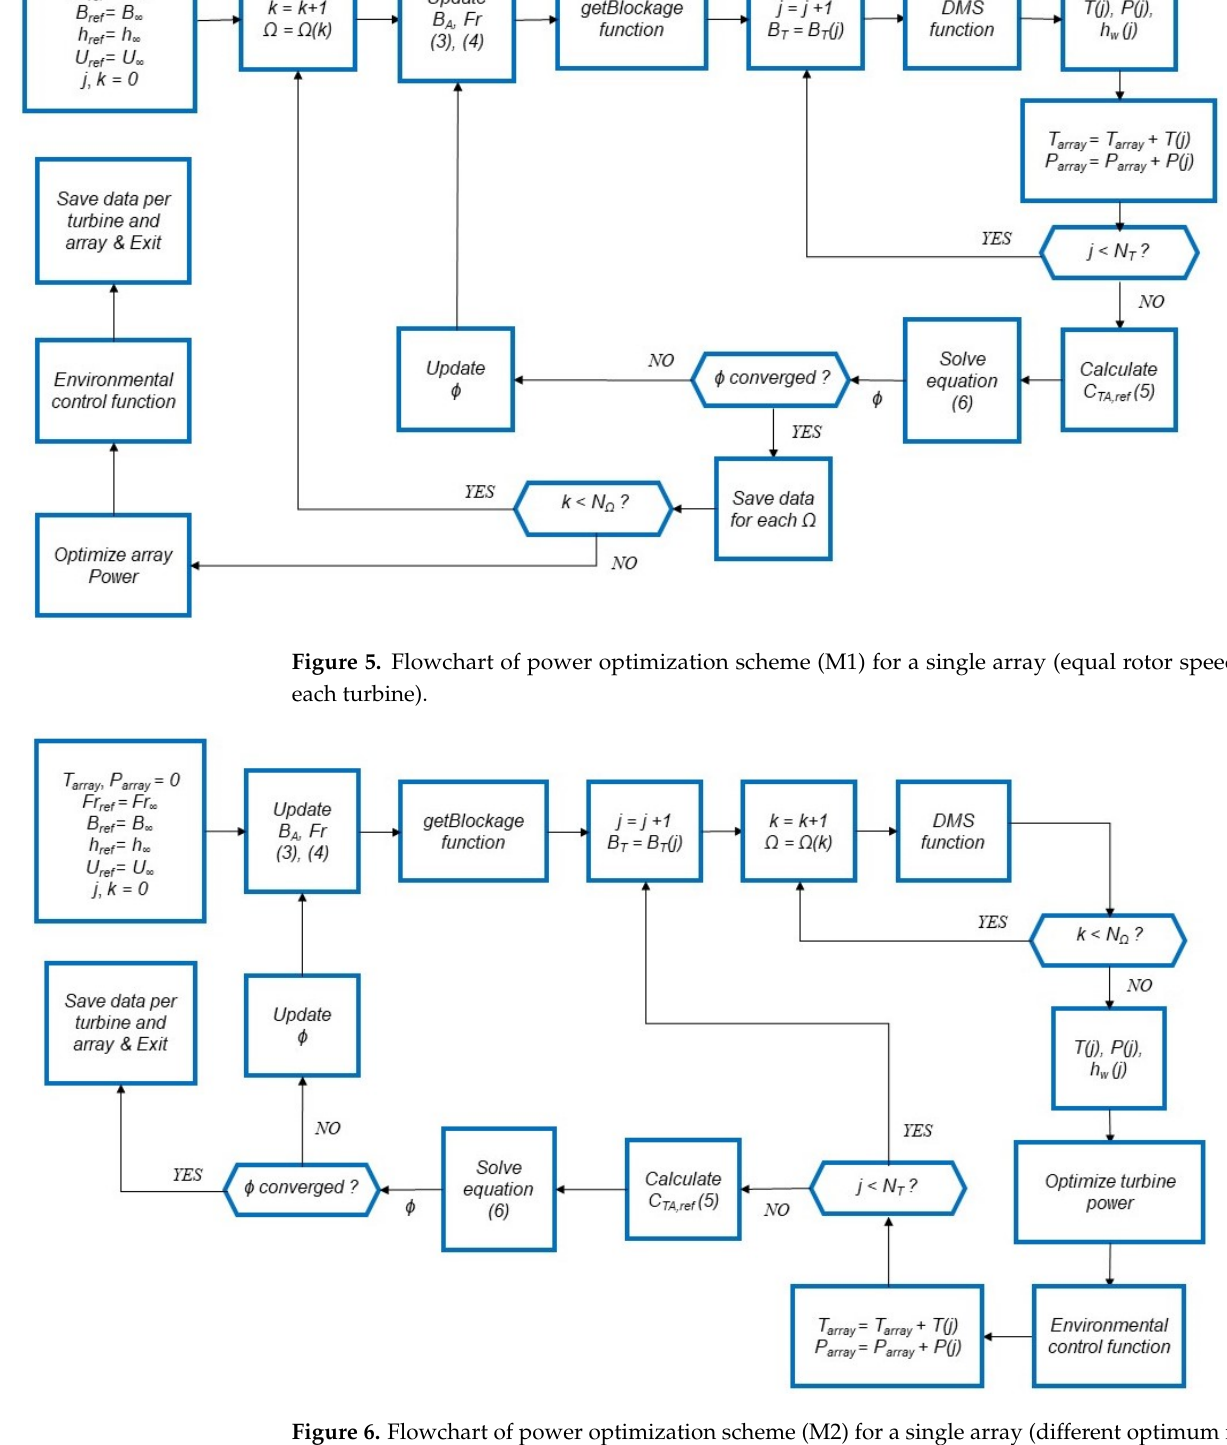
Figure 6. Flowchart of power optimization scheme (M2) for a single array (different optimum rotor speeds for each turbine).